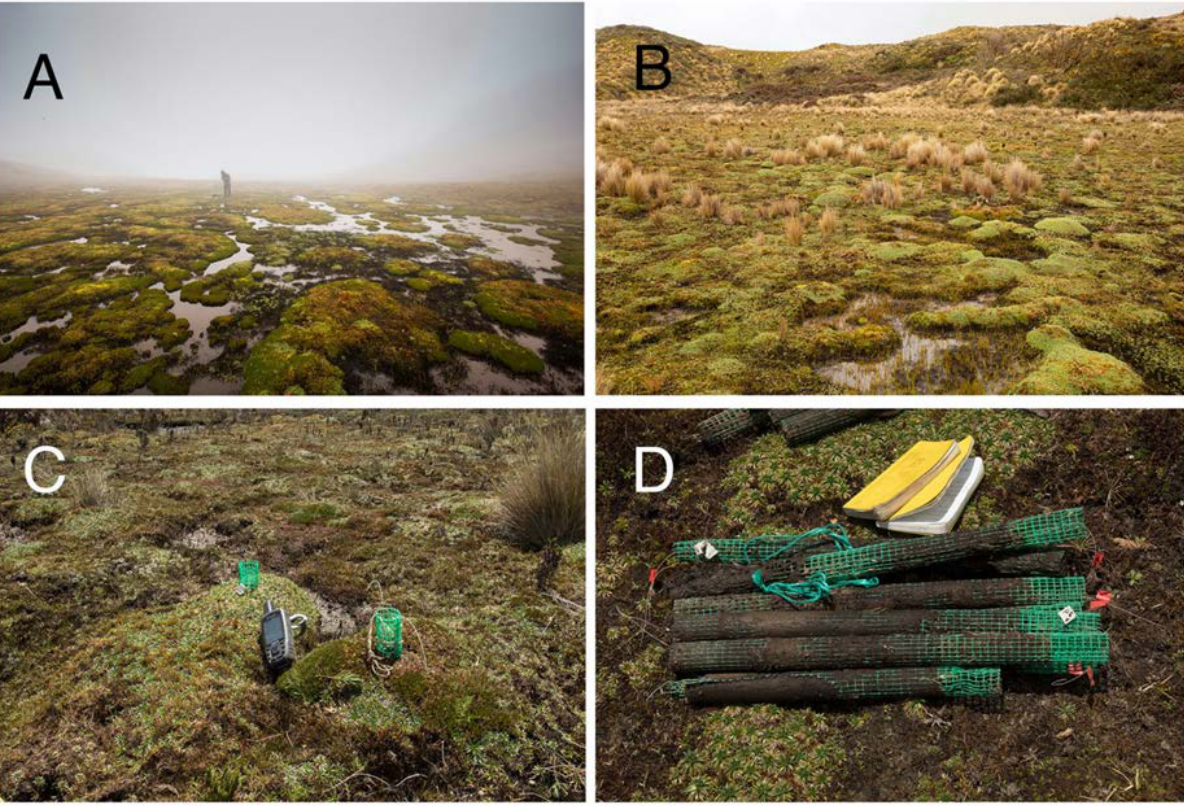
Figure 1. Study sites located in the páramos of Cayambe-Coca National Park (Northern Ecuador), on cushion plant dominated peatlands at (A) 4300 m a.s.l. and (B) 4200 m a.s.l. Panels C and D depict the ingrowth bags that were used to measure root